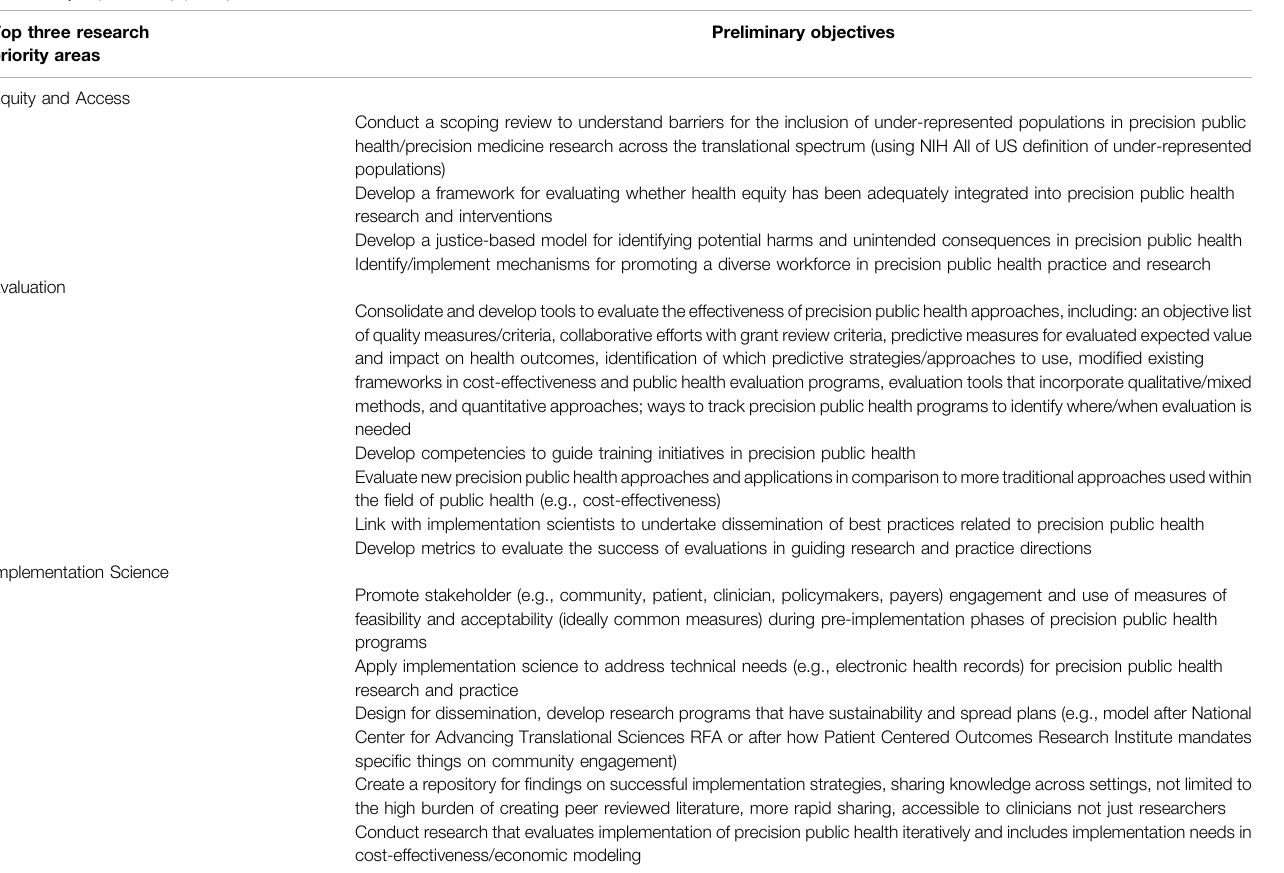
TABLE 3 | Objectives by